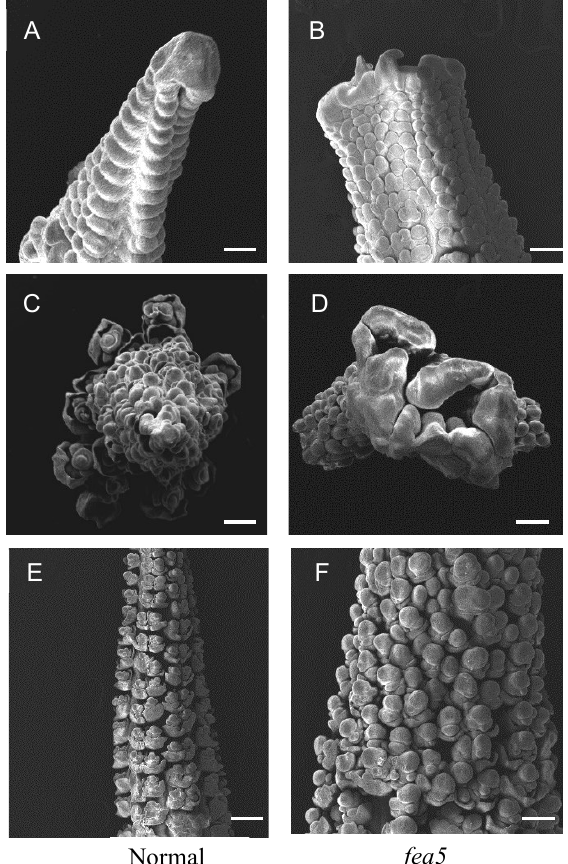
Figure 2. Microscopic phenotypes of fea5 mutants. fea5 ear IMs were enlarged and flattened in ( B , D ), whereas normal ears had tapered, conical shaped IMs ( A , C ). Bars = 500 mm. Normal ears occurred as a gradual progression and generated pairs of spikelets that remain aligned regularly ( E ), whereas in fea5 ears, the plane of SPM branching was disrupted ( F ).